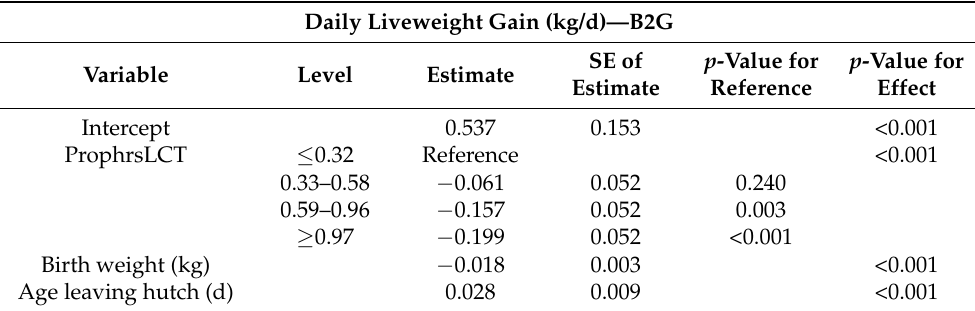
Table 5. Final model describing variables affecting daily liveweight gain (DLWG) from birth until entering the group housing igloo pen